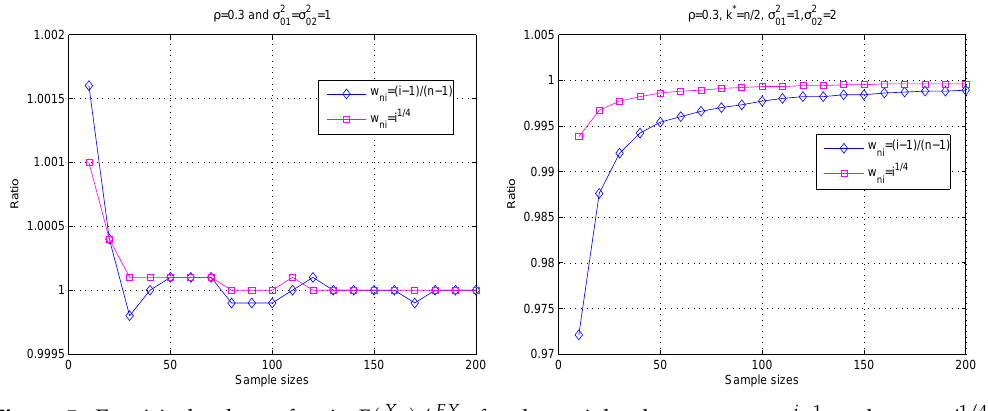
and w ni = i 1/4 , n − 1